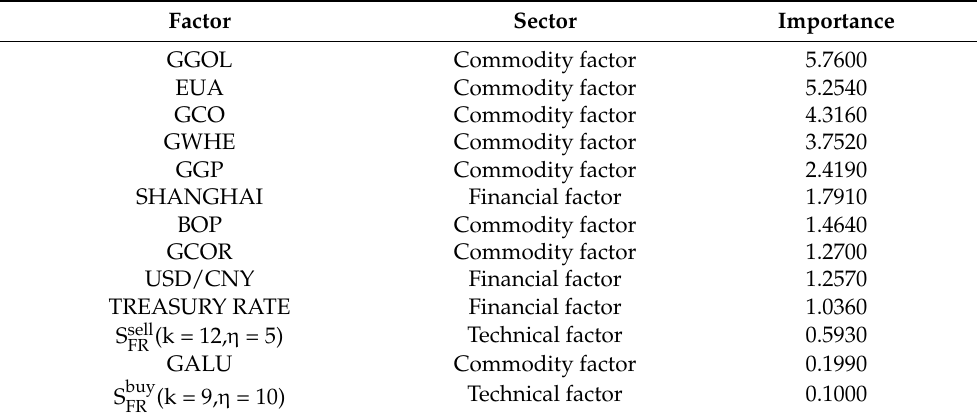
Table 6. Description of the most important selected factors, using LASSO.